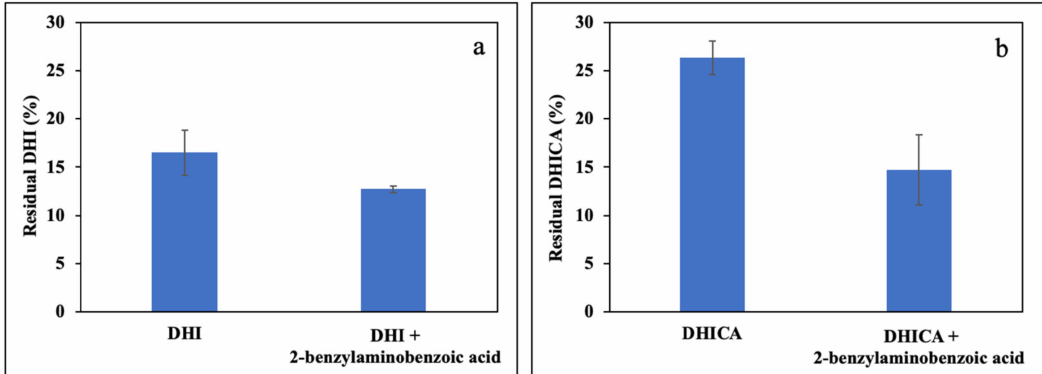
Figure 5. Residual concentration of: ( a ) DHI; or ( b ) DHICA after 1 h photooxidation in the presence of 1 µ M RF and with or without equimolar 2-benzylaminobenzoic acid. Data are expressed as mean ± SD of three independent experiments, each performed in duplicate.